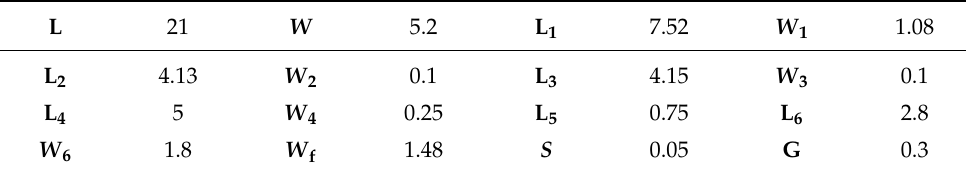
Figure 6. Schematic diagram of the dual-notched UWB BPF. Table 1. Proposed filter dimensions in mm.